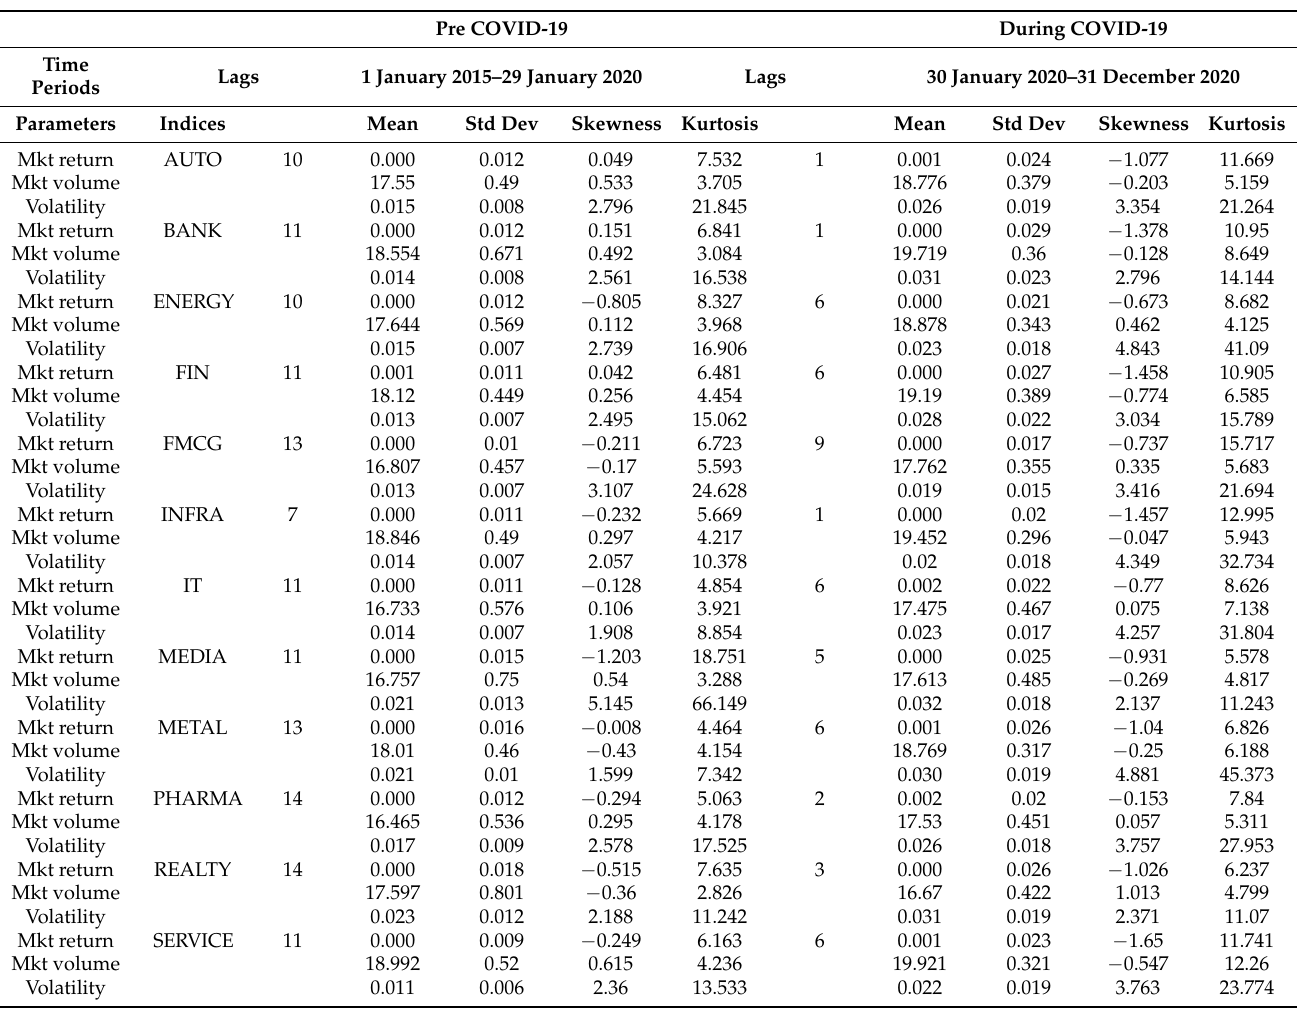
Table 1. Descriptive